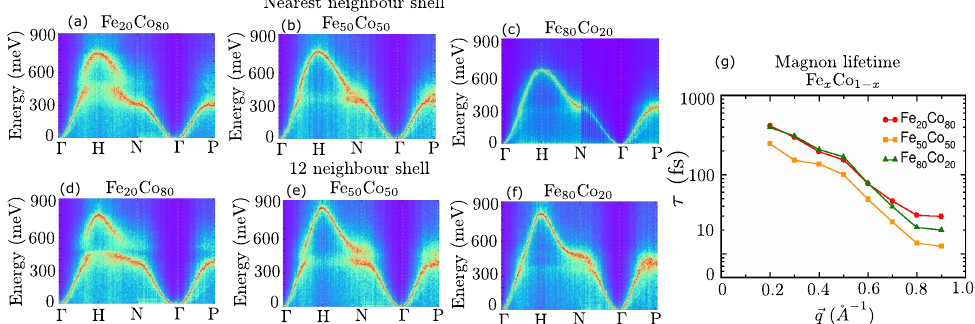
Figure 3. The figures in the top row ( a – c ) show the magnon dispersion of Fe x Co 1 − x (where x = 0.2, 0.5 and 0.8) alloys with nearest-neighbour exchange parameters and the bottom row figures show the plots ( d – f ) with the 12 neighbour shell exchange parameters. ( g ) Magnon lifetimes for disordered Fe x Co 1 − x alloys for x = 0.2, 0.5 and 0.8 from